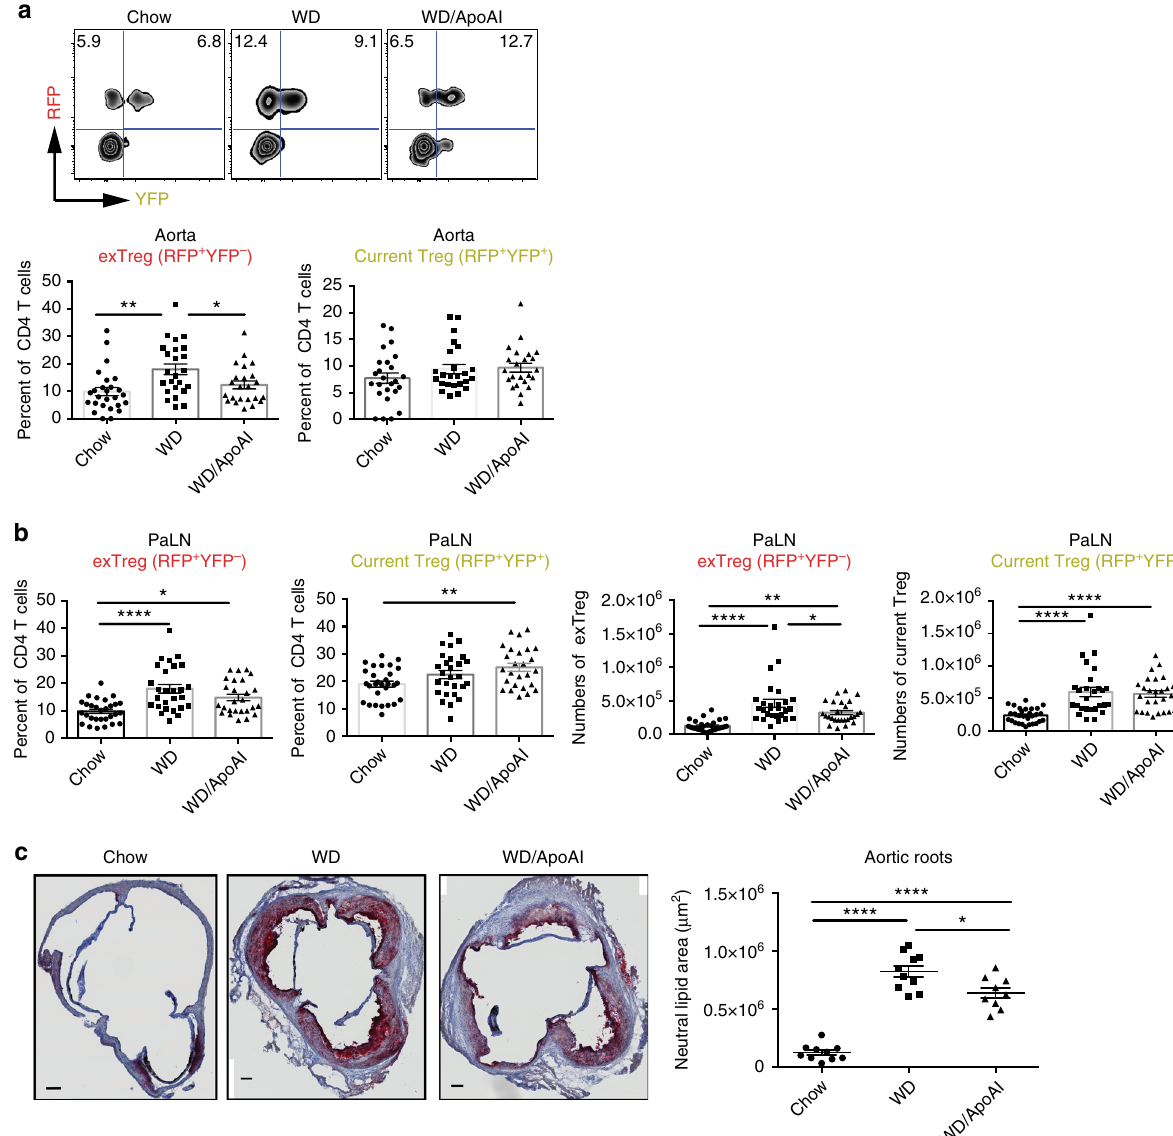
Fig. 6 ApoAI administration reduces exTreg during atherogenesis. ( a , b ) LT-ApoE − / − mice were fed western diet and after 6 weeks, human lipid free ApoAI (500 μ g per mouse)(or BSA as control) were given subcutaneously 3 times per week for 9 weeks. Mice were sacri fi ced after 15 weeks and aorta and PaLN were harvested for analysis. Flow cytometry plots and graphs showing the percentages and/or numbers of RFP + YFP − (exTreg) and RFP + YFP + (current Treg) in the aorta ( a ) and PaLN ( b ). Results are expressed as the mean ± s.e.m. from four independent experiments ( n = 29 (Chow), n = 27 (WD) and n = 26 (WD/ApoAI)). c Aortic roots from the above mice groups were sectioned and stained with Oil Red O. Images are representative sections from each group of mice. The amount of red pixels in each section was determined and the corresponding area was calculated. Each individual dot in the graph is the average of 8 sections per aorta per mouse. Scale bars = 100 μ m. Results are expressed as the mean ± s.e.m. from three independent experiments ( n = 10 (Chow and WD) and n = 9 (WD/ApoAI)). Statistical signi fi cant differences were at * P < 0.05, ** P < 0.01, and **** P < 0.0001 (one-way